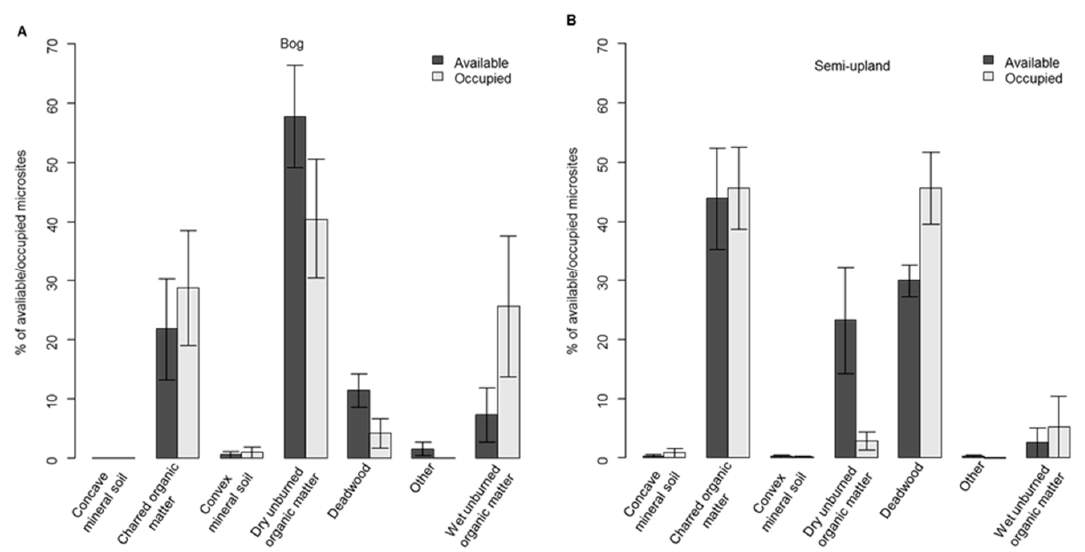
Commented [B13]: Define if appropriate Commented [PB14R13]: Removed.